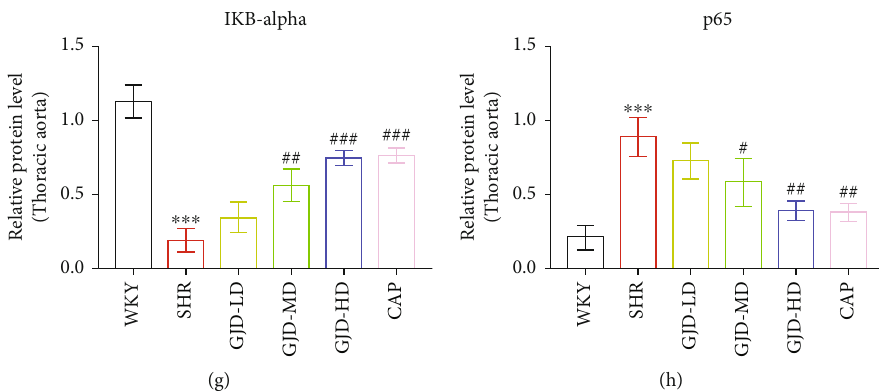
Figure 3: E ff ect of GJD on the expression of TAK1, IkB-alpha, and p65. The expression of TAK1, IkB-alpha, and p65 in the left ventricular and aorta was examined by western blot. (a) The left ventricular expression of TAK1, IkB-alpha, and p65, and (b) the aorta expression of TAK1, IkB-alpha, and p65. The bar charts indicate relative protein levels referenced to β -actin. WKY indicates the WKY control group, SHR indicates the SHR model group, GJD-LD indicates the SHR treated with GJD at a low dose, GJD-MD indicates the SHR treated with GJD at a medium dose, GJD-HD indicates the SHR treated with GJD at a high dose, and CAP indicates SHR treated with captopril. Data are means ± SD . n = 3 . ∗ P < 0 : 05 , ∗∗ P < 0 : 01 , ∗∗∗ P < 0 : 001 vs. WKY group. # P < 0 : 05 , ## P < 0 : 01 , ### P < 0 : 001 vs. SHR